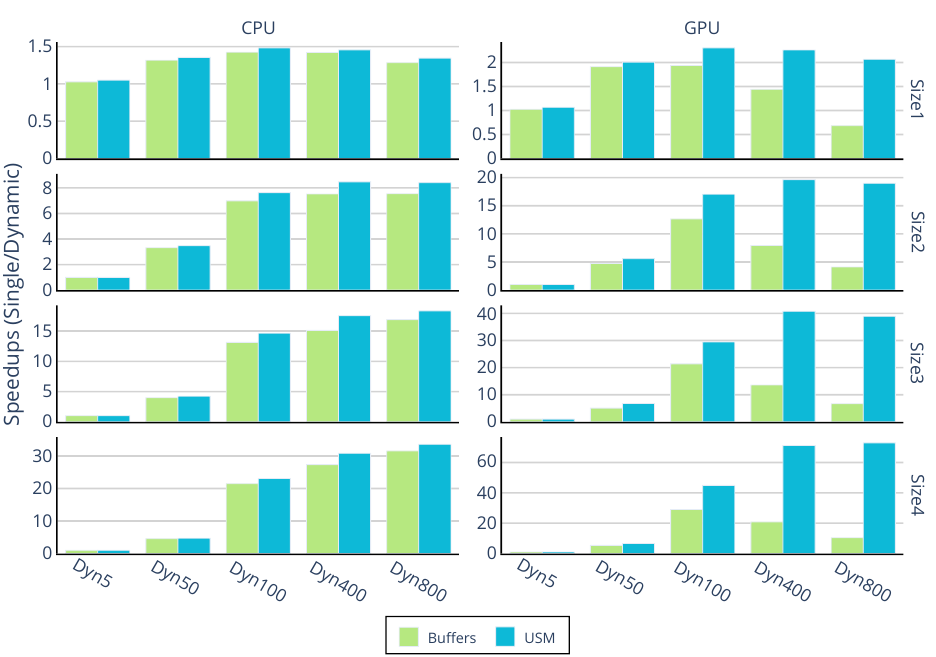
Figure 11. NBody speedups when using single-device dynamic policies for a set of increasing problem sizes. Baselines are single CPU or GPU execution per memory